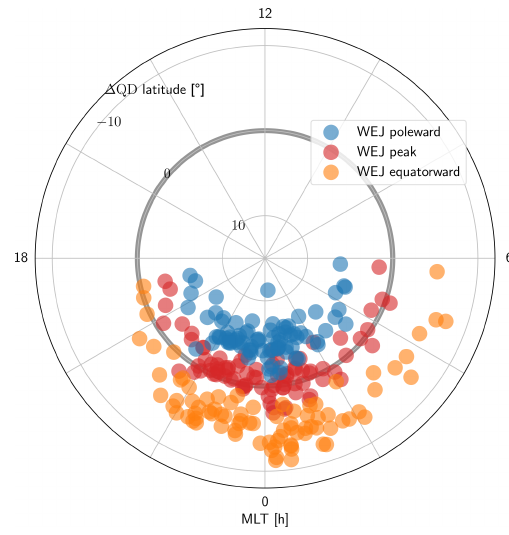
Figure 9. The temporal evolution of the WEJ median current and extent of the jet in polar ((cid:49) QD ,(cid:49) MLT ) coordinates.